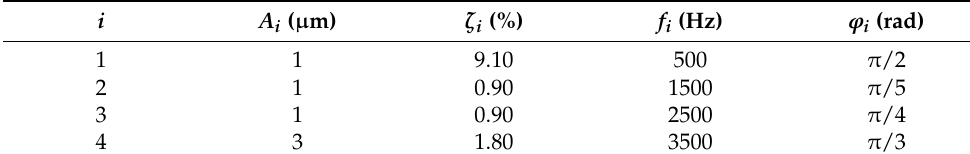
Table 1. The values of the simulation parameters in Equation (10).